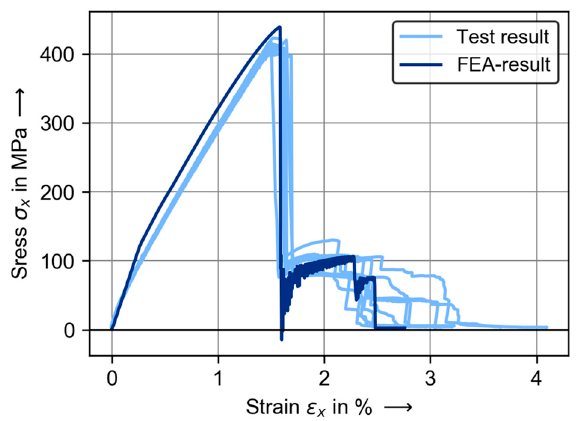
Table 5. Experimentally determined and numerically predicted mechanical properties for a multi- directional SCFRP with a steel fiber volume fraction of approx. 20%.